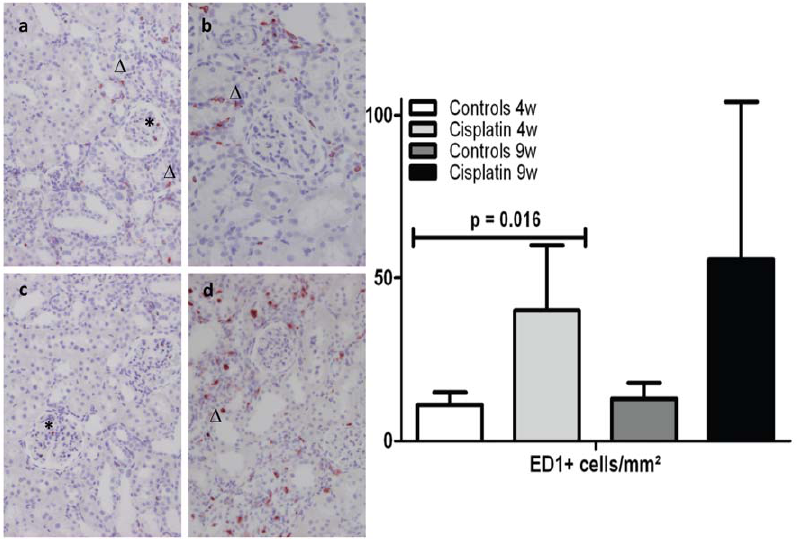
Figure 2. Interstitial and glomerular ED1 infiltration. Left part: ED1 positive cell in a glomerulus (*) and in the interstitium ( n ) of a) a control rat at 4 weeks; b) a cisplatin-treated rat at 4 weeks; c) a control rat at 9 weeks and d) a cisplatin-treated rat at 9 weeks. Right part: Effect of cisplatin on the infiltration of ED1-positive cells. Results are expressed as the mean 6 SD of the absolute numbers of immunoreactive cells per mm 2 , each group containing n=6. Statistics were performed using generalized linear models.